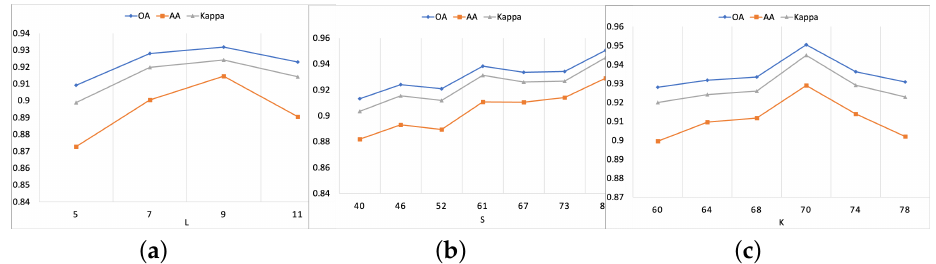
Figure 6. Effects of different L , S and K on the OA, AA, and Kappa on KSC dataset. ( a ) Setting S and K to 0.8 L 2 , the influence of the change of L on OA, AA, Kappa; ( b ) Setting L to 9, K equals S , the effect of S on OA, AA, Kappa; ( c ) After the values of L and S were determined, the effect of K change on OA, AA, and Kappa was